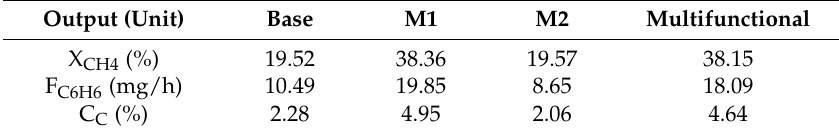
Table 2. Base case performance criteria results. Base uses no membrane, M1 uses H 2 -permeable membrane, M2 uses O 2 -permeable membrane, and multifunctional uses both